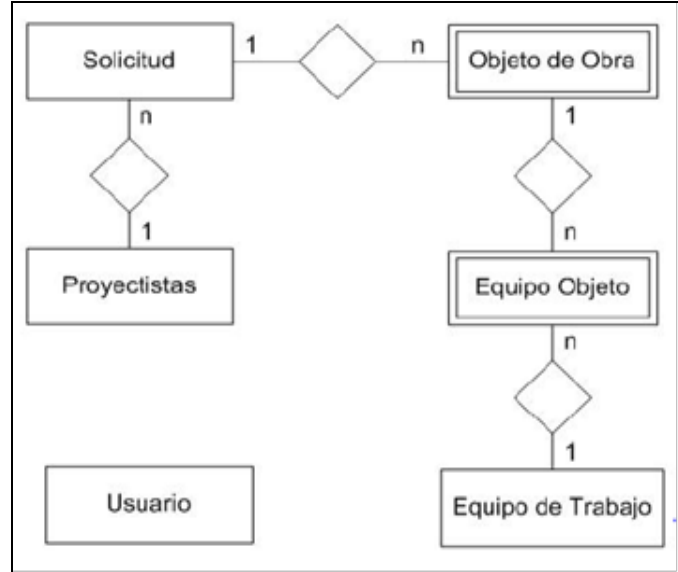
Figura 1 : Diagrama Entidad - Relación del diseño de la Base de